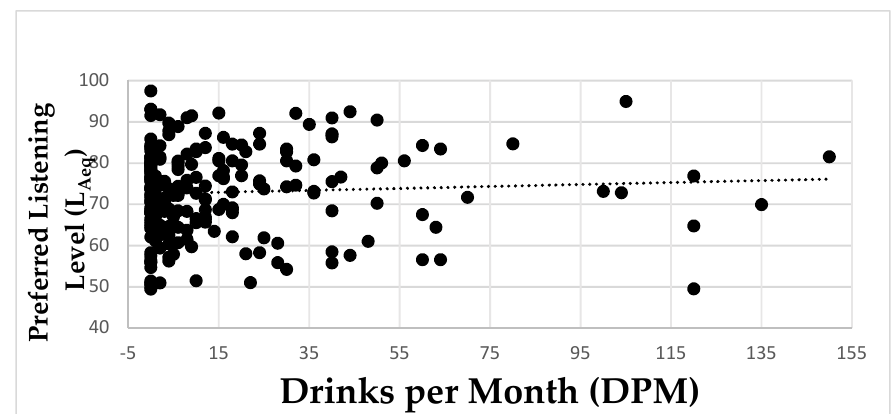
Figure 4. The scatterplot for drinks per month (DPM) and preferred listening level (L Aeq ) is shown for all 216 participants. The linear regression line is also shown.